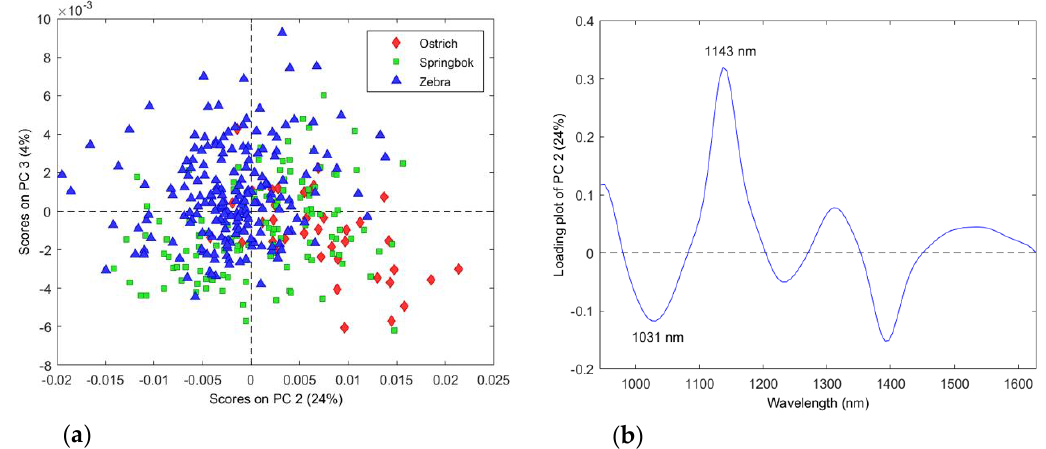
Figure 1. Principal component analysis (PCA; Savitzky–Golay first-derivative, second-order polynomial, seven points (SGd 1 (7) pre-processed) of species for ostrich ( red ), springbok ( green ), and zebra ( blue ) classes. Minimal class separation was observed. Scores are illustrated as ( a ) the PCA score plot of PC2 (24%) vs. PC3 (4%), and ( b ) the PCA loading line plot for PC2 with interpretable bands at 1031 and 1143 nm.